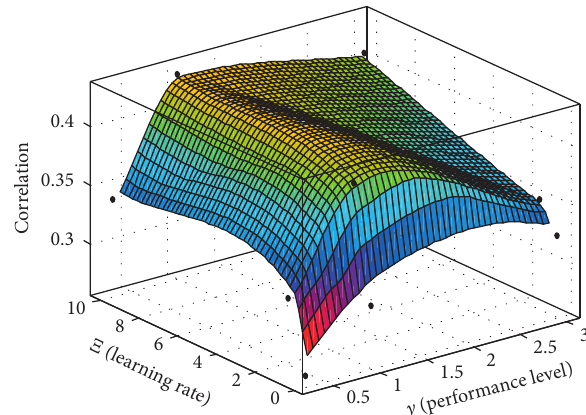
Figure 16: The correlation between measuring error and the tur- bulence with respect to the learning rate and the performance level.